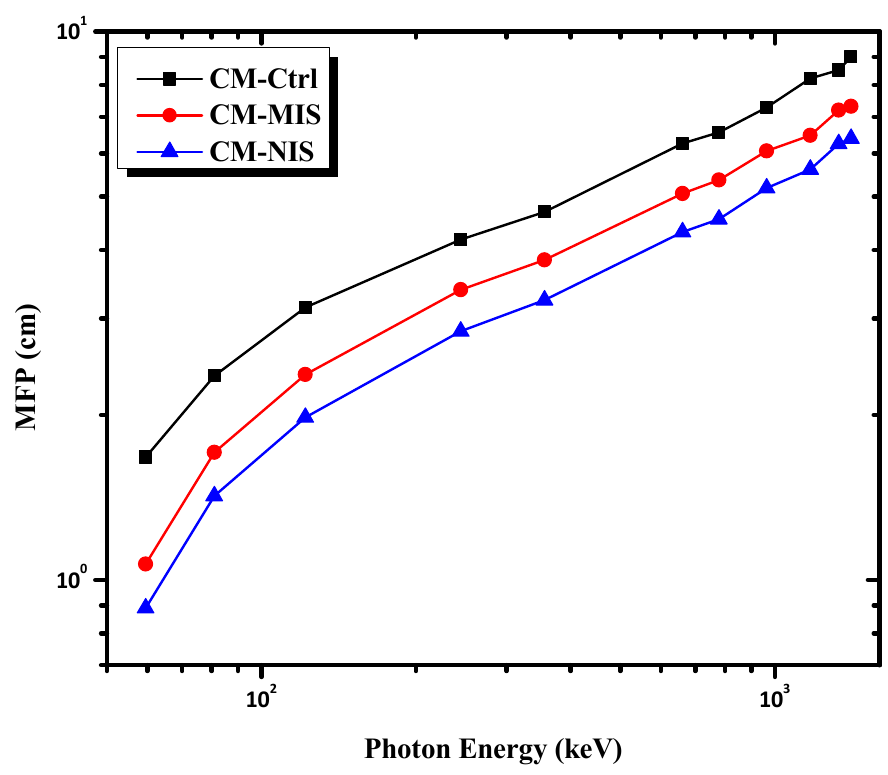
Figure 8. The variation of the mean free path as a function of photon energy.